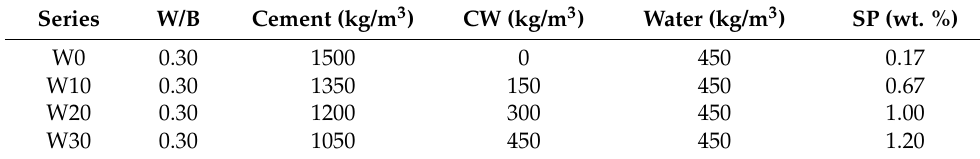
Table 2. The Ratios of Raw